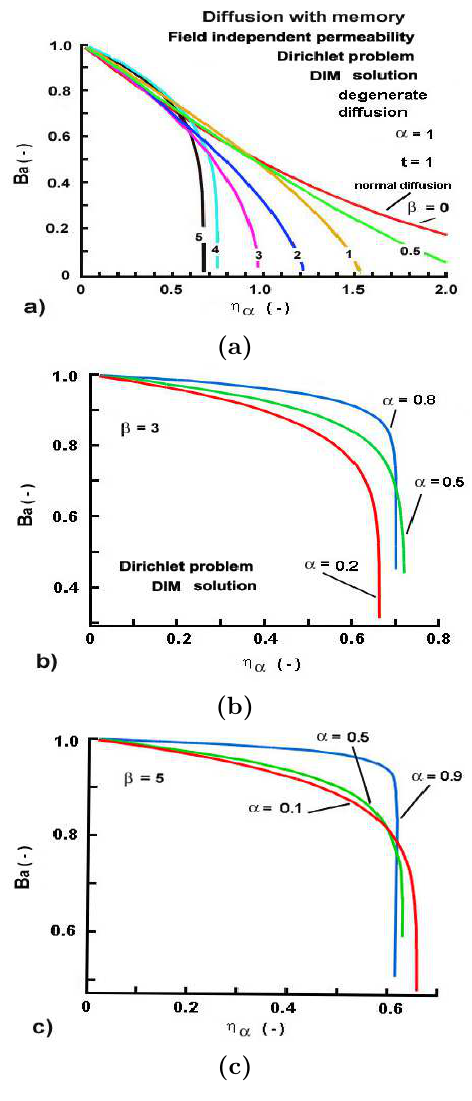
Figure 5. Approximate profiles for stipulated exponent n = 2 (a) and optimal n opt = 2 . 248 (b) compared to exact